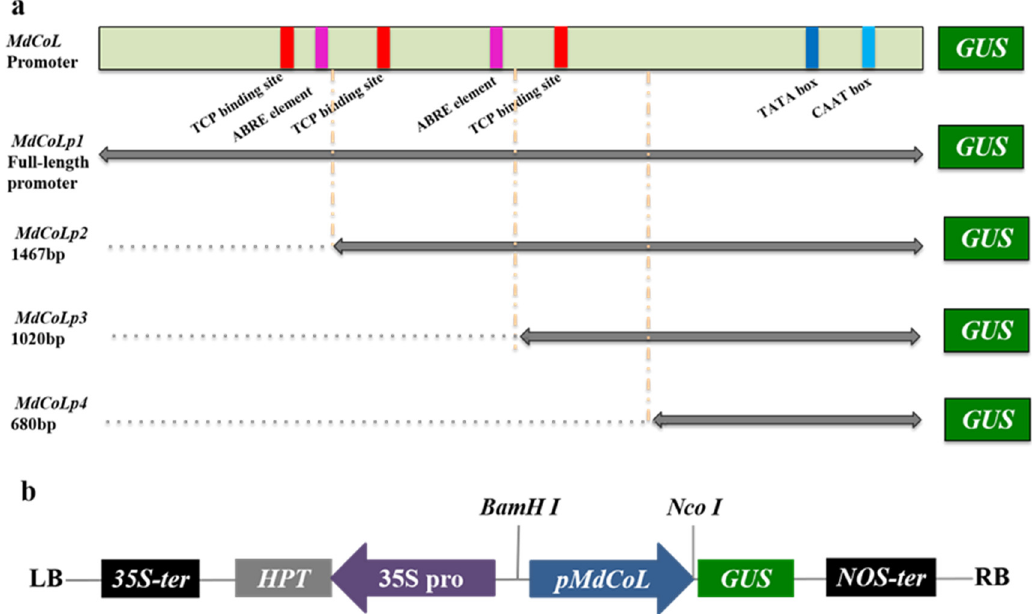
Figure 3. The scheme of MdCoL promoter constructs for Arabidopsis transformation. ( a ) The constructs diagram of MdCoL promoter with different length. ( b ) Schematic diagram of the expression vector for promoter activity detection, in which the expression vector pCambia1301 was used to clone the MdCoL promoter at the BamHI and NcoI sites. The transcription factors’ binding sites and cis-acting elements located on the MdCoL promoter were indicated by squares of different colors.